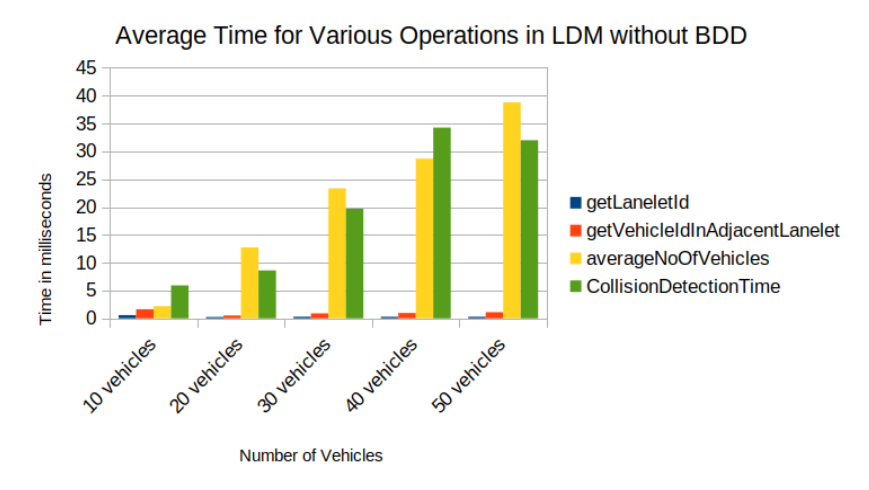
Figure 16. Time in milliseconds for operations (get ego vehicle lanelet id, get vehicles ids in adjacent lanelets of ego vehicle, average of vehicles in adjacent lanelets, collision risk warning algorithm from Shimada et